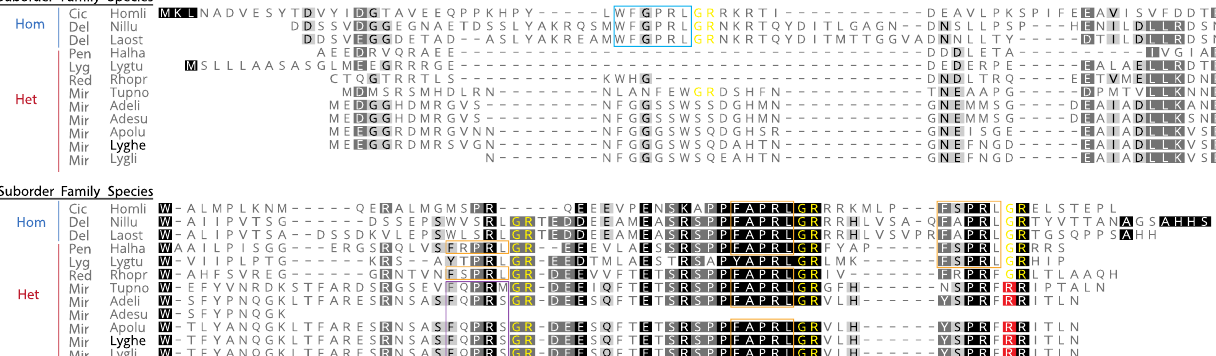
Figure 3. Alignment of hemipteran PK-like prepropeptides. The Lygus hesperus PK (LyghePK) sequence is indicated in black font. PK species abbreviations and accession numbers are: Homli ( Homalodisca liturata ; GECU01033249.1); Nillu ( Nilaparvata lugens , BAO00974.1); Laost ( Laodelphax striatellus , RZF43903.1); Halha ( Halyomorpha halys , AYP97818.1); Lygtu ( Lygaeus turcicus , GCYB01067468.1); Rhopr ( Rhodnius prolixus , ADA83379.1); Tupno ( Tupiocoris notatus , GFBA01045781.1); Adeli ( Adelphocoris lineolatus , GGBQ01031033.1); Adesu ( Adelphocoris suturalis , GGBU01027748.1); Apolu ( Apolygus lucorum , KAF6216512.1); Lygli ( Lygus lineolaris , GCXM01012899.1). Family abbreviations are: Cic, Cicadellidae; Del, Delphacidae; Pen, Pentatomidae; Lyg, Lygaeidae; Mir, Miridae. Suborder abbreviations are: Hom, Homoptera; Het, Heteroptera. Potential processing sites that result in C-terminal amidation are shown in yellow font. PK1 sequences are boxed in blue, FXPRL sequences characteristic of PK2s are boxed in orange, a mirid specific FXPRL-like motif (FQPRS/M) is boxed in purple, and mirid specific losses of C-terminal amidation sites are highlighted in red. The alignment was performed with predicted signal peptides excluded.